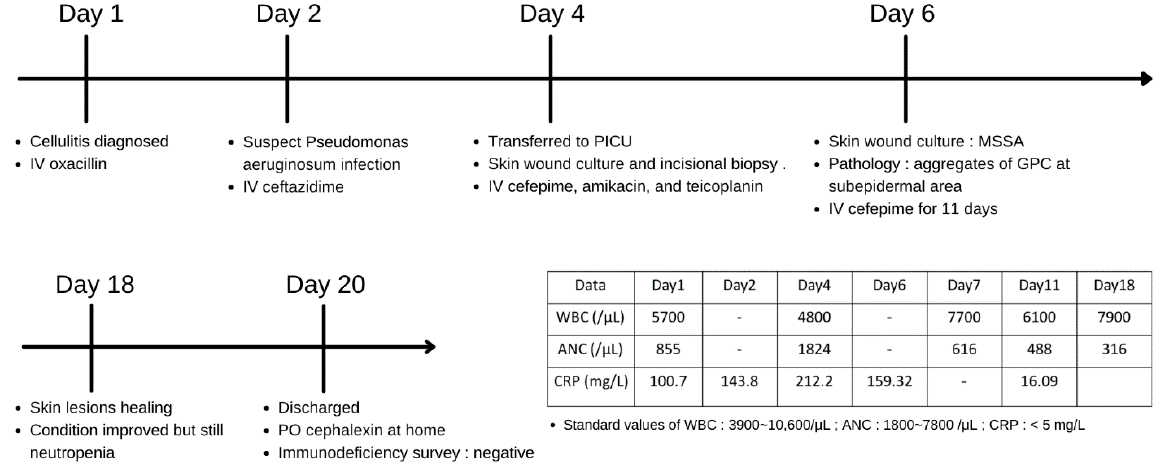
Figure 3. The flow charts of presenting symptoms, laboratory data, and treatment courses in the hospital days.